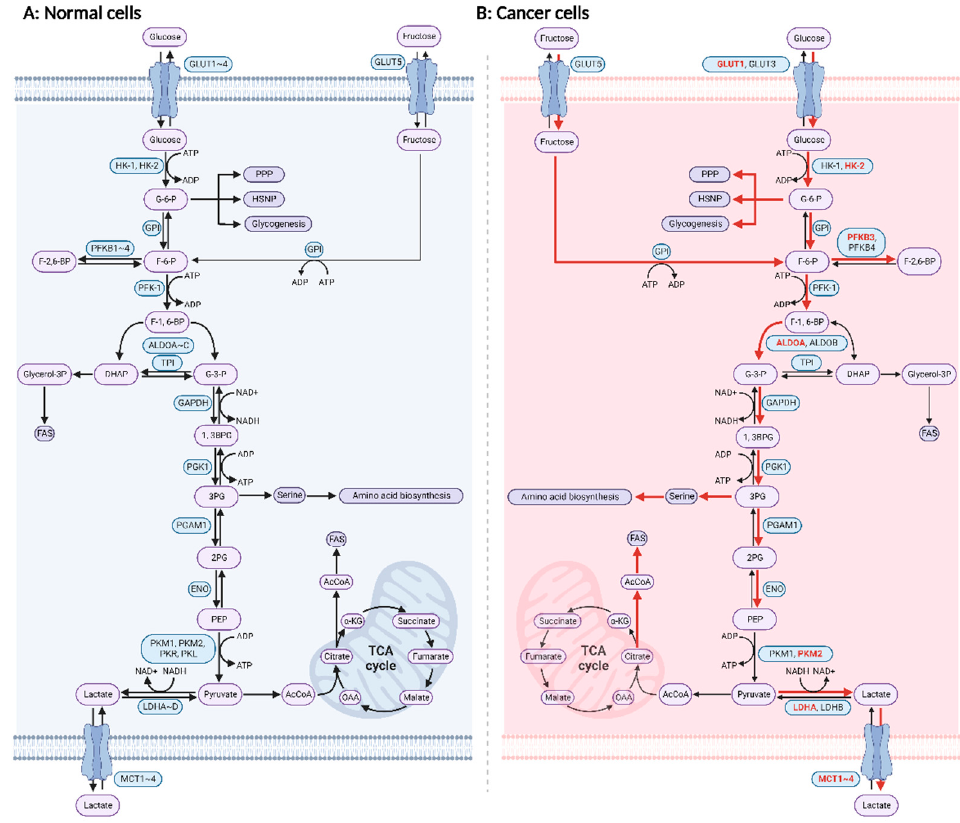
Figure 1. Reprogramming of glucose metabolism in cancer cells. ( A ) Glucose metabolism in normal cells; ( B ) glucose metabolism in cancer cells. Cellular uptake of glucose is followed by a series of reactions to transform glucose to pyruvate. Then, glucose enters the TCA cycle or is converted to lactate. Enzymes or pathways predominant in cancer cells are shown in bold red. Created with BioRender.com (accessed on 22 August 2022). Abbreviations: 1,3 BPG, 1,3-bisphosphoglycerate; 2-PG, 2-phosphoglycerate; 3-PG, 3-phosphoglycerate; α -KG, α -ketoglutarate; AcCoA, acetyl coenzyme A; ADP, adenosine diphosphate; ALDO, aldolase; ATP, adenosine triphos- phate; DHAP, dihydroxyacetone-phosphate; ENO, enolase; F-1,6-BP, fructose-1,6-bisphosphate; F-2,6-BP, fructose-2,6-bisphosphate; F-6-P, fructose-6-phosphate; FAS, fatty acid synthesis; G-3-P, glyceraldehyde-3-phosphate; G-6-P, glucose-6-phosphate; HK, hexokinase; LDH, lactate dehydro- genase; GAPDH, glyceraldehyde-3-phosphate dehydrogenase; GCK, glucokinase; GLUT, glucose transporter; glycerol-3P, glycerol-3-phosphate; GPI, glucose-6-phosphate isomerase; MCT, monocar- boxylate transporter; OAA, oxaloacetate; PEP, phosphoenolpyruvate; PFK1, phosphofructokinase 1; PFKFB, 6-phosphofructo 2-kinase/fructose-2,6-bisphosphatase; PGAM1, phosphoglycerate mutase 1; PGK1, phosphoglycerate kinase 1; PK, pyruvate kinase; PPP, pentose phosphate pathway; TCA, tricarboxylic acid; TPI, triosephosphate